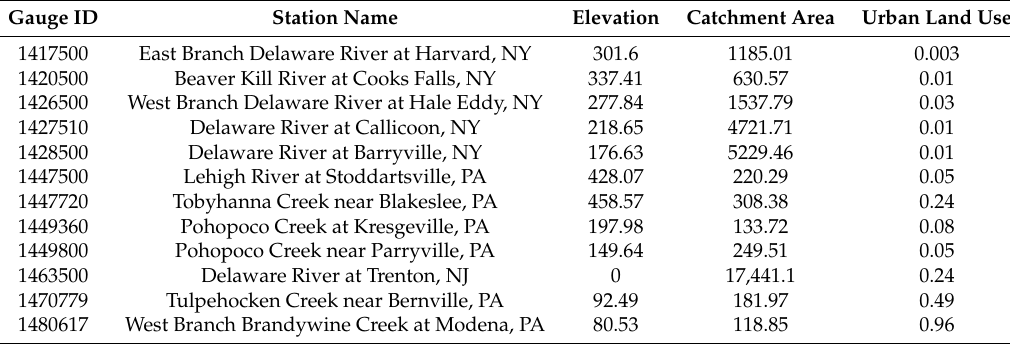
Table 1. List of study sites, including the U.S. Geological Survey gauge ID, elevation (m), catchment area (km 2 ) and the proportion of urban land use in the catchment upstream of study